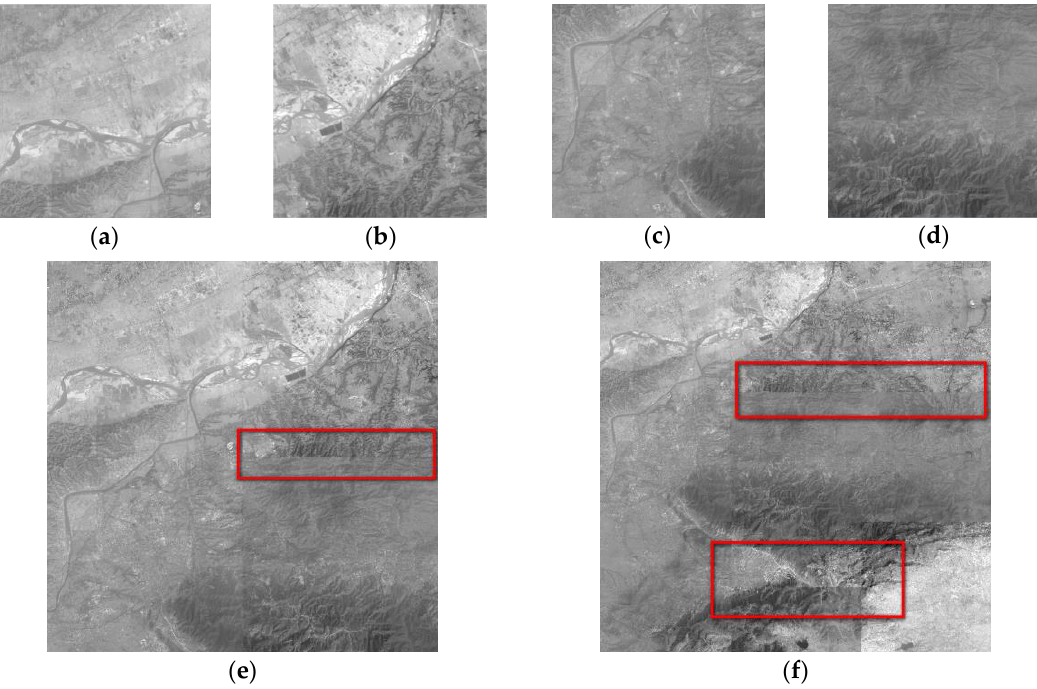
Figure 11. Results of the quadtree method: ( a ) 64 images; ( b ) 64 images; ( c ) 64 images; ( d ) 64 images; ( e ) 256 images; and ( f ) 576 images.